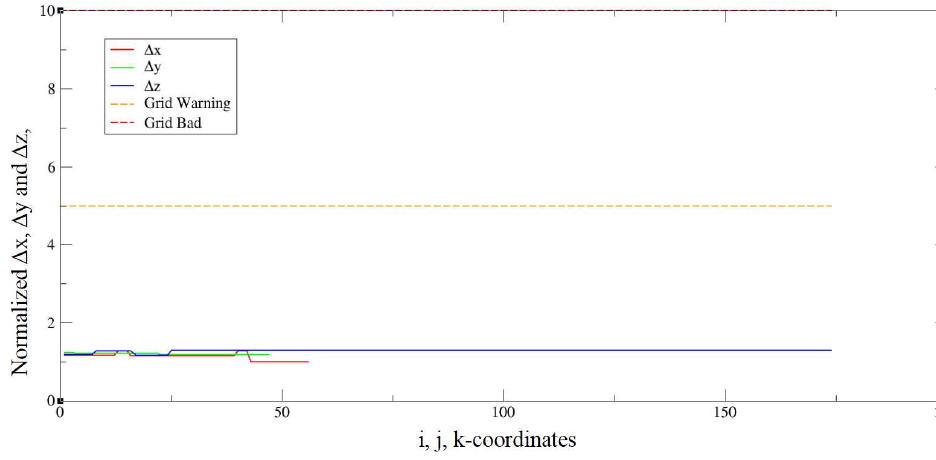
5 of 17 Figure 1. Model setup and grid generation of the biomass CFBB.